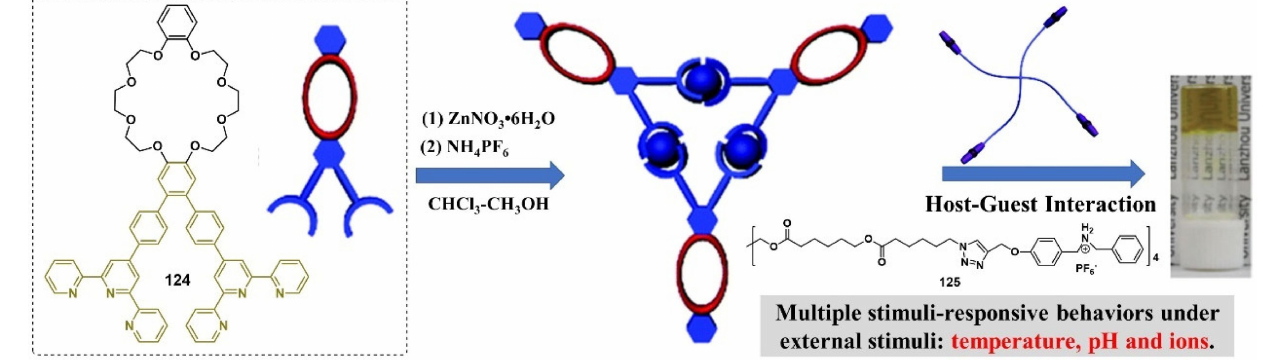
Figure 51. Cartoon representations of a cross-linked three-dimensional supramolecular polymeric network from ligand 124 , Zn 2+ , and bis-ammonium salts 125 . Reprinted with permission from Ref. [133]. Copyright (2016), Royal Society of